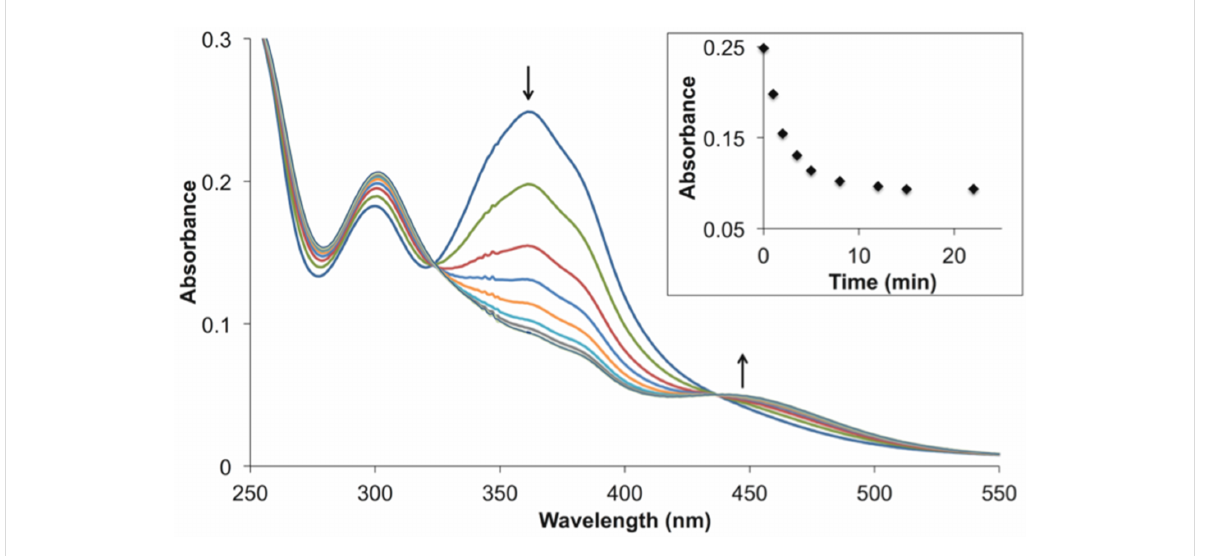
Figure 3: Electronic absorption spectra showing changes associated with photoisomerization of 1 E (40 μ M) to 1 Z in aqueous 0.03 M MOPS buffer at pH 7.2 in the presence of KCl (0.1 M) and EGTA (0.011 M). Inset: Absorbance at 362 nm as a function of irradiation time.